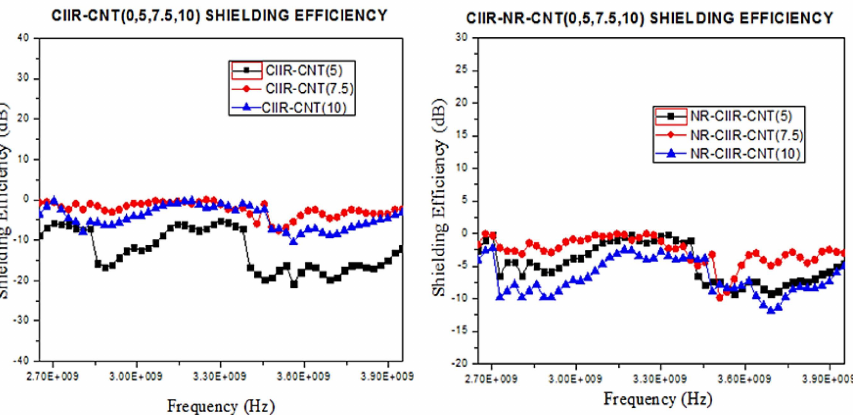
Figure 17. EMI shielding effectiveness frequency dependencies of CIIR and CIIR/NR blend rubber nanocomposites with different filler